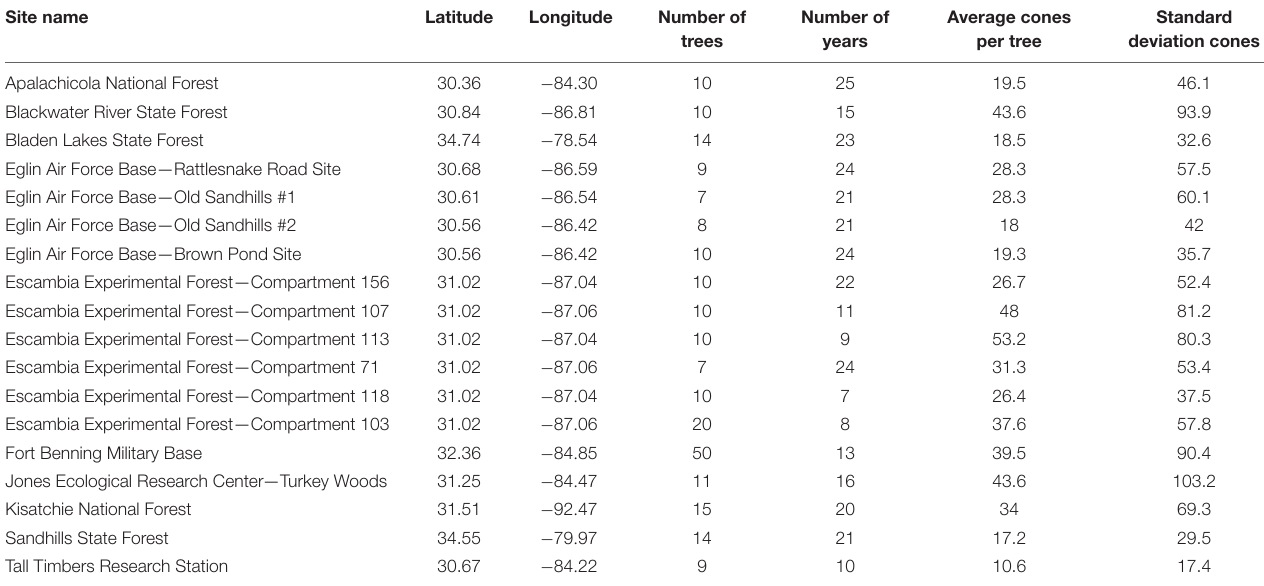
TABLE 1 | Site information listed alphabetically and descriptive statistics for each of the 18 cone count